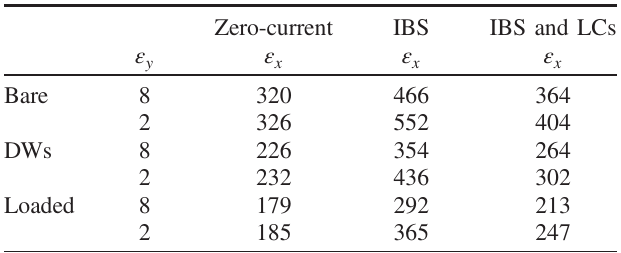
TABLE I. Emittance (in pm rad) in the MAX IV 3 GeV storage ring for different settings of coupling and three lattice configu- rations: bare lattice, lattice with damping wigglers (equivalent to a moderately ID-equipped ring), and a fully ID-equipped ring. Emittance blowup from IBS with and without bunch lengthening from LCs was calculated assuming 500 mA stored current and rf cavities set to maximum